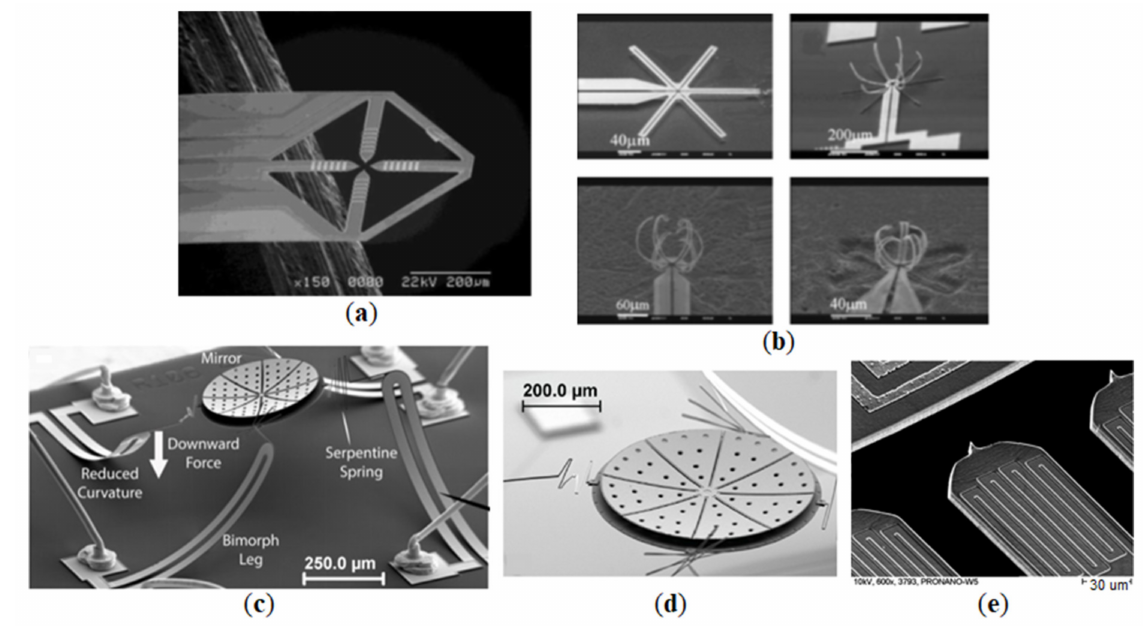
Figure 10. Applications of bimorph actuators: ( a ) 4-finger microgripper [110]; ( b ) microcage [111]; ( c ) micromirror [112]; ( d ) varifocal micromirror [112] ( e ) scanning probe